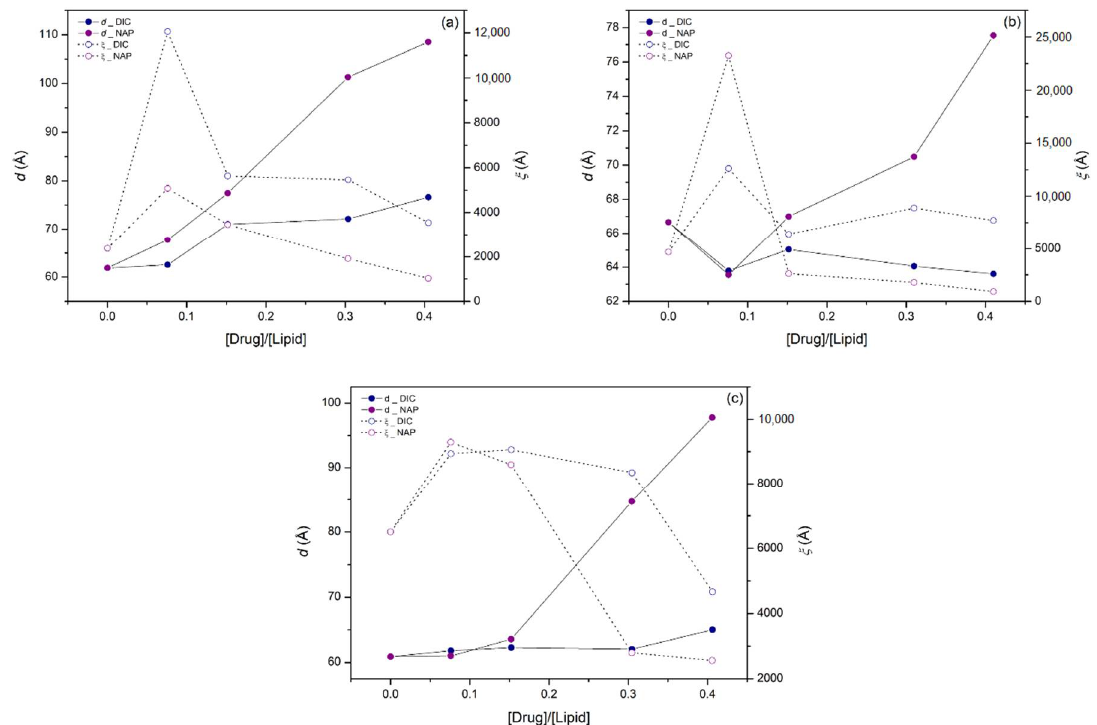
Figure 6. Long-range distance ( d, solid circles, solid line) and correlation length ( ξ , open circles, dashed line) corresponding to the most intense first-order Bragg peak of ( a ) POPC:CHOL (80:20), ( b ) POPC:CL (85:15), and ( c ) POPC:PI (85:15) bilayers at 37 °C and pH 7.4 as a function of drug:lipid molar ratio. DIC (blue circles) and NAP (purple circles) induced effects were calculated from the average SAXS profiles.